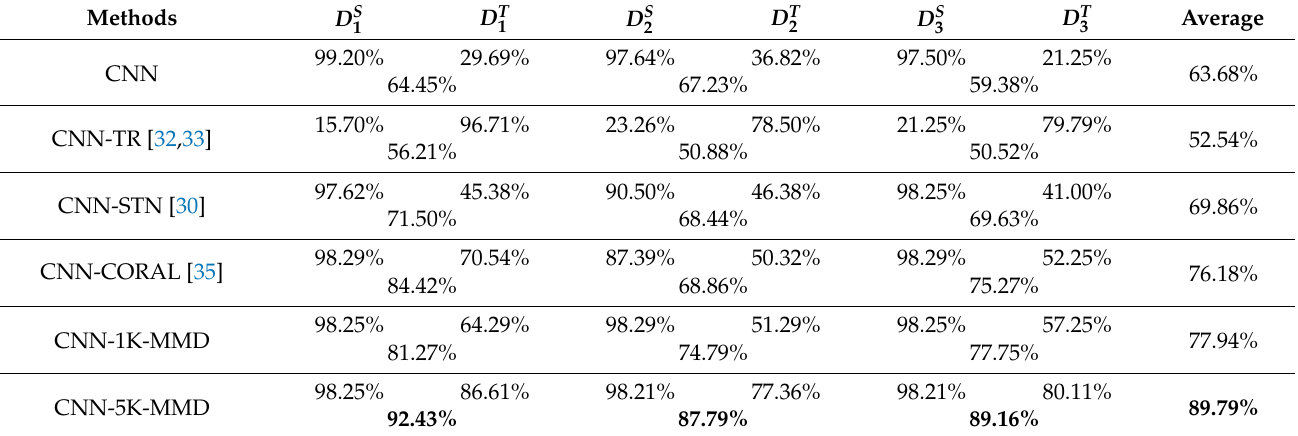
Table 5. Classification Accuracy comparison with state-of-the-art